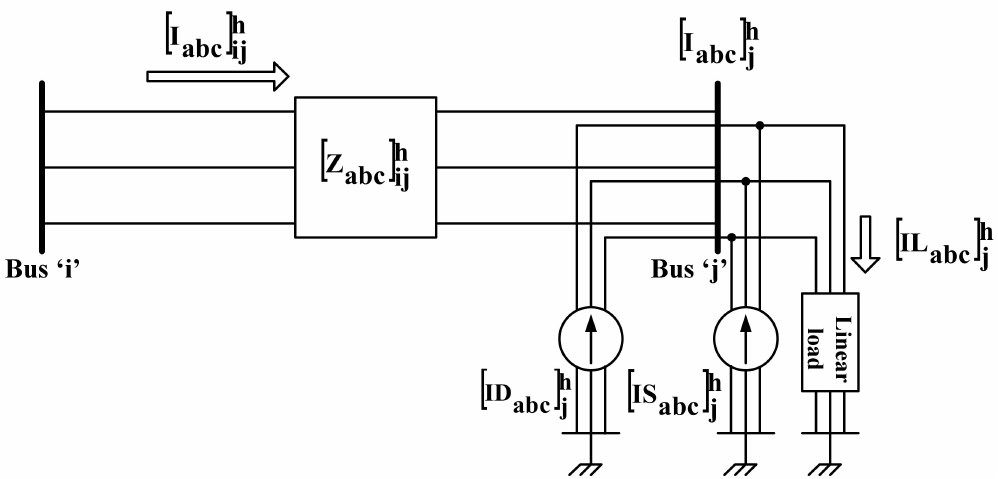
Figure 6. Sample section of two buses for